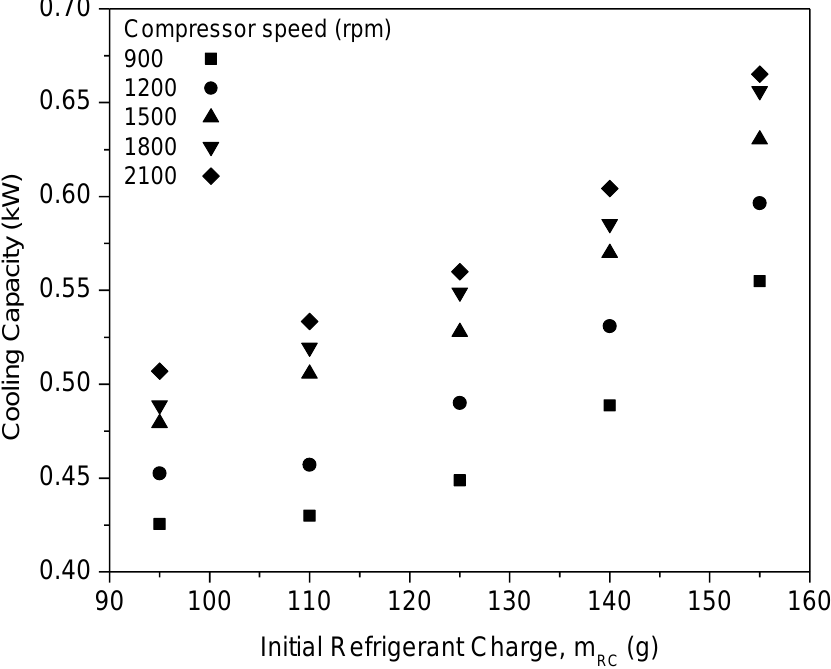
Figure 6. Cooling capacity of pure PAG at various refrigerant charges and compressor speeds.